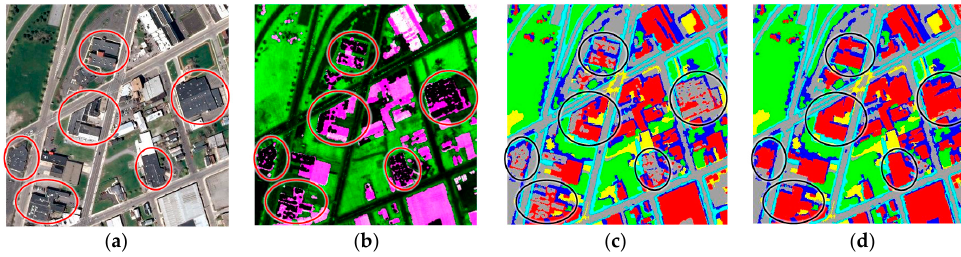
Figure 18. Fusion for no-data areas of LiDAR data: ( a ) high-resolution image, ( b ) LiDAR data, ( c ) joint classification map using LiDAR data and high-resolution image before object-based post- classification fusion, and ( d ) classification map after object-based post-classification fusion.